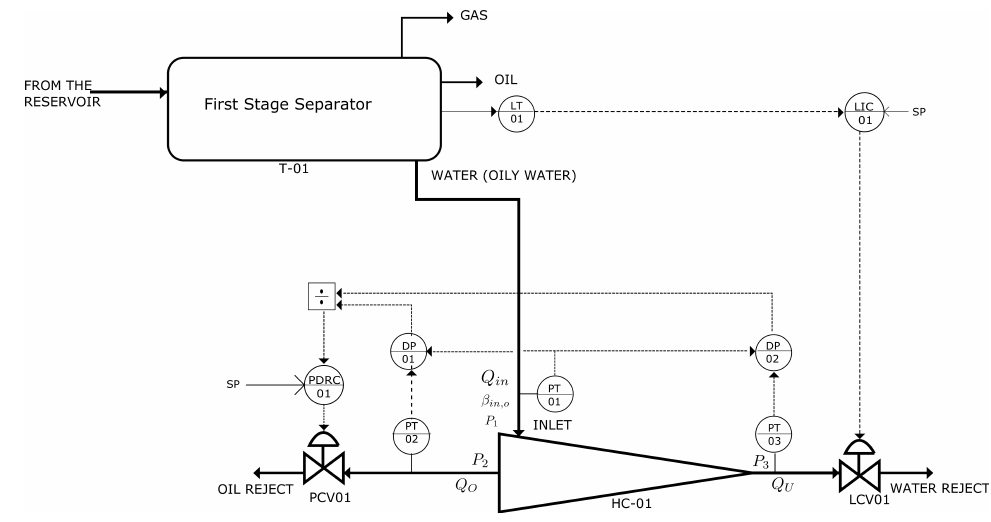
Figure 2: A typical control scheme of hydrocyclone representing flow rate and flow split control characterizes an efficiency plateau, in which the oil- water separation is more effective (see Figure 3). This is achieved by manipulating the underflow control valve LCV01. In turn, the flow split control aims at main- taining a sufficient overflow rate in the hydrocyclone. The objective is to have good separation and main- tain efficiency. The overflow control valve PCV01 is